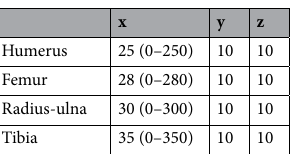
Table 3. Binning of histograms according to bone